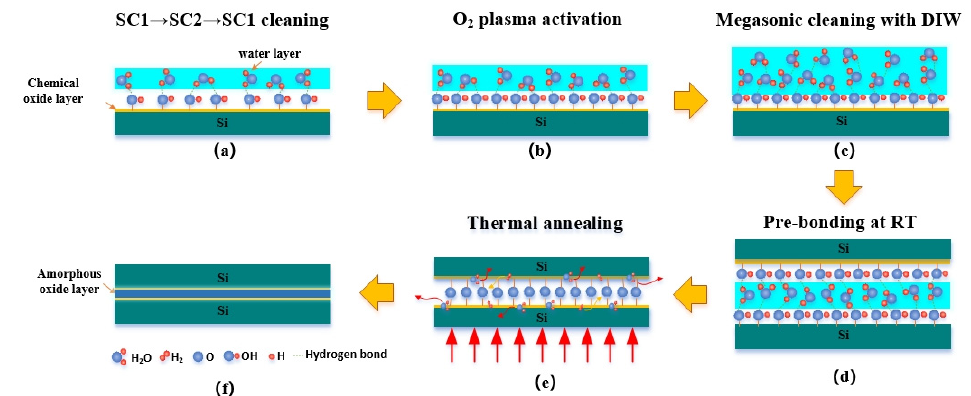
Figure 2. Schematic diagram of combined hydrophilic activation. ( a ) The Si wafers were cleaned by SC1 → SC2 → SC1 solution, and the wafer surface is covered by Si-OH; ( b ) More dangling bonds and water molecules are on the Si wafer surface after O 2 plasma activation; ( c ) An increase of thickness of hydration film on the Si wafer surface due to the megasonic cleaning; ( d ) The two wafers pre-bond at room temperature by hydrogen bonds and Si-OH bonds; ( e ) The Si-OH bonds convert into Si-O-Si bonds as thermal annealing occurs. ( f ) An amorphous oxide layer at the bonding interface is formed and strong bonding is achieved.